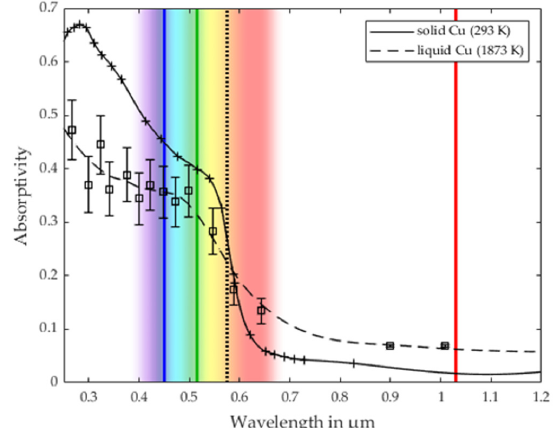
Figure 2. Absorptivity of solid (solid line) and liquid copper (dashed line) measured at room temperature and at 1873 K. The vertical blue, green and red lines indicate the wavelengths of commercial high-power blue, green and IR beam sources at 450 nm, 515 nm and 1030 nm, respectively, as a guide to the eye. The vertical black dash-dotted line indicates the X-point at ∼ 575 nm . For the data of solid copper, the measurement accuracy is not explicitly given in the